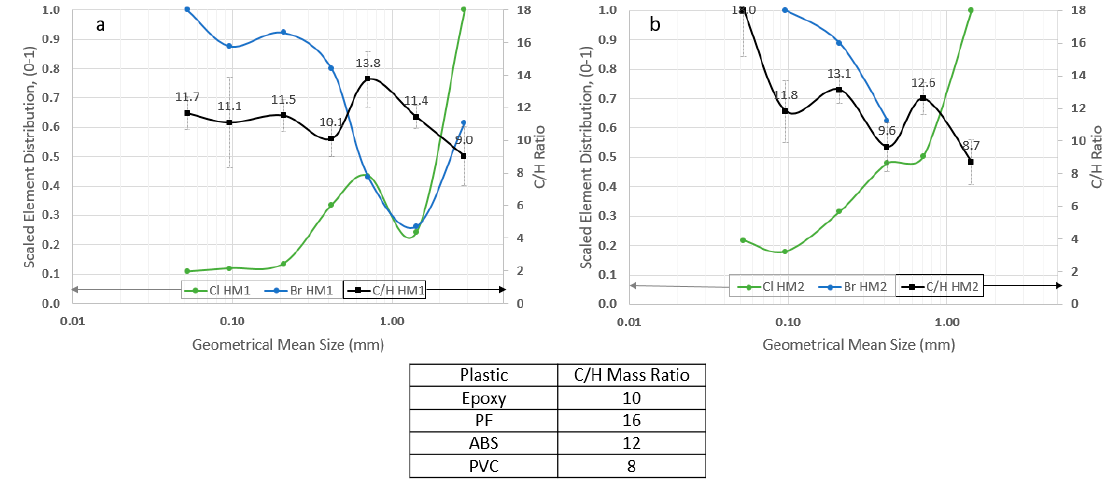
Figure 3. Scaled distribution of Cl and Br in comparison with the C / H mass ratio as a function of the geometric mean size of the products of ( a ) Hammer Mill 1 and ( b ) Hammer Mill 2. The absolute uncertainty for the C / H ratio is given as an error bar. Experimental data points are connected with lines for the purpose of visual aid only.